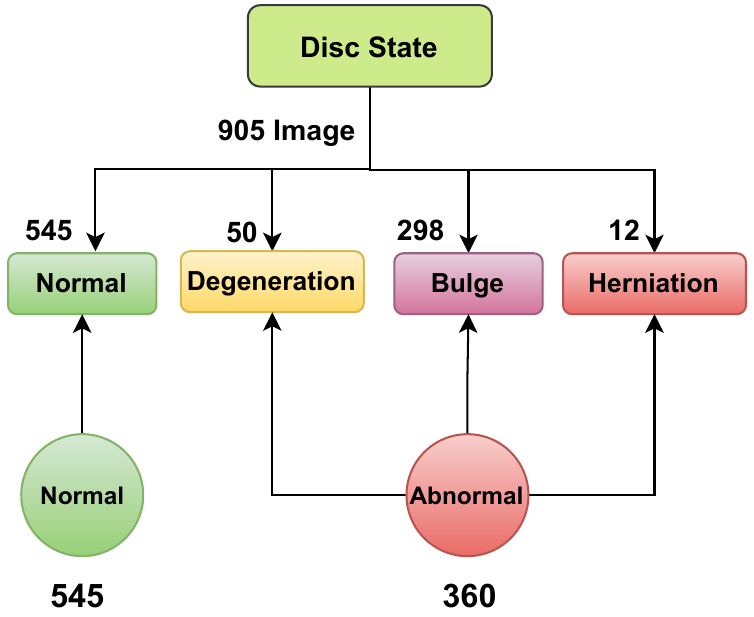
Figure 4. Number of axial T2 images in disc state for each